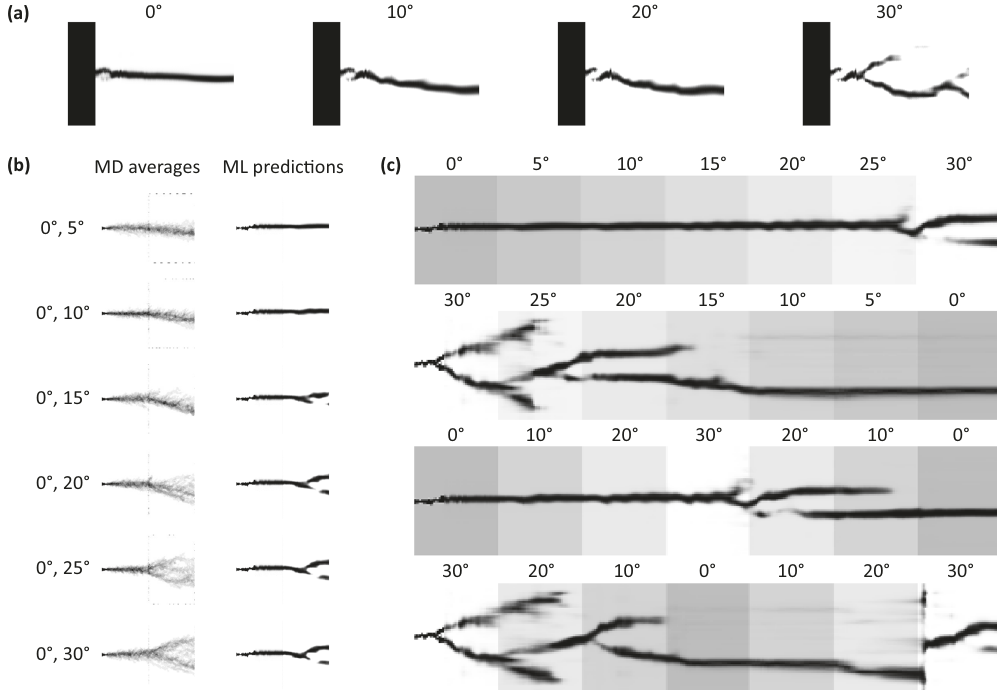
Fig. 4 Generalized fracture prediction. Despite being trained on exclusively pre-notched graphene samples, the model can a reasonably predict crack nucleation given a pristine free surface. Furthermore, the ML model can quickly and easily predict fracture in increasingly complex graphene systems including b bicrystal graphene of various misorientation angles and c linear and sinusoidal gradients of orientation within a larger scale